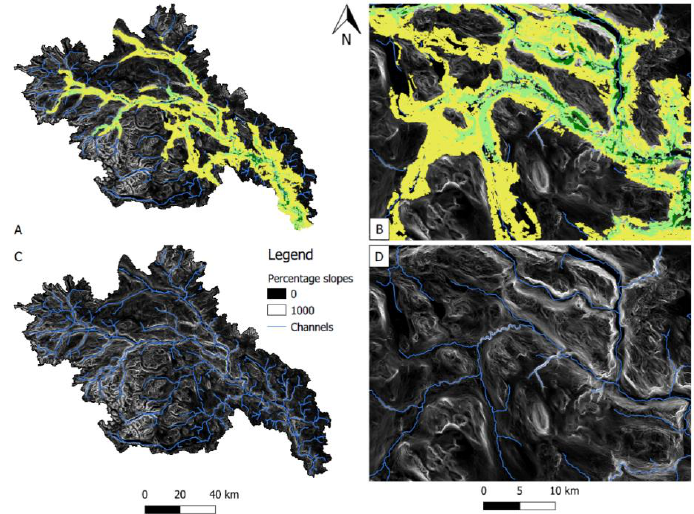
Figure 2. Percentage slopes of the whole Gudbrandsdalen catchment ( A , C ), and a selected zoom area (522,282 m E, 6,842,455 m N, UTM32) ( B , D ). A and B show the delineation of the productive forest areas based on the national forest site index map. Low, medium, and high productivity areas are displayed in yellow, light green, and dark green, respectively. C and D show the streams (Strahler stream order higher than 8) overlaid onto the slope map (%) calculated from the digital terrain model (DTM) at 10 m resolution.